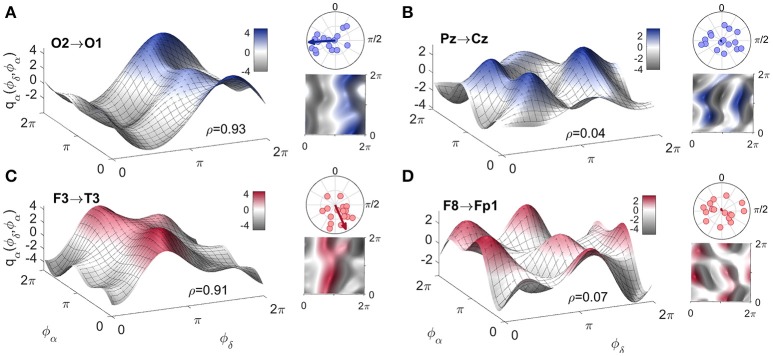
Examples of inter-subject averages of coupling functions between particular pairs of probes. They have been selected for generating (A,C) the highest and (B,D) the lowest similarity indices, as shown. The arrows in the polar plots in the top right corners of each panel indicate the similarity indices for the averaged coupling functions, while the dots indicate the similarity indices for individuals. Note that in B and D the arrows are of negligible dimension. A complementary 2D color-contour plot of the coupling function is given in the bottom right-hand corner of each panel.